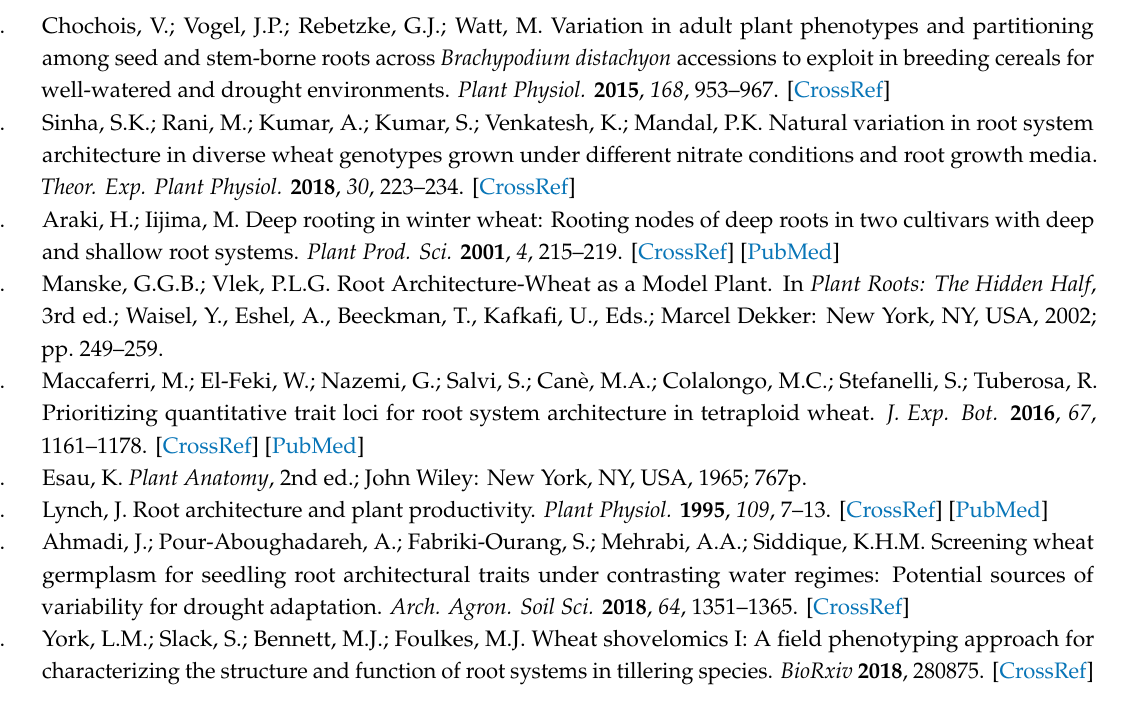
Table S1. Mean values and standard errors (12 replications) of the seminal root traits for the 37 durum wheat genotypes. Table S2: Descriptive statistics and correlation coe ffi cients for seedling traits, calculated separately for the cultivar and landrace groups. Table S3: Results of linear regressions of traits over years of release. Table S4: Contribution (%) of the traits to the first two principal components (PC1, PC2), as represented in Figure 3A. Table S5: Means comparison between groups formed by hierarchical clustering for the traits assessed. Figure S1. (A) One-week-old durum wheat seedlings in the rhizoslide system; (B) pictures of two genotypes contrasting for root angle, landrace Gloire de Montgolfier (left) and cultivar Oued El Berd (right); (C) schematic representation of a glass box, holding 6 glass plates, each holding two rhizoslides. Figure S2: Time trend of seminal root traits over the year of